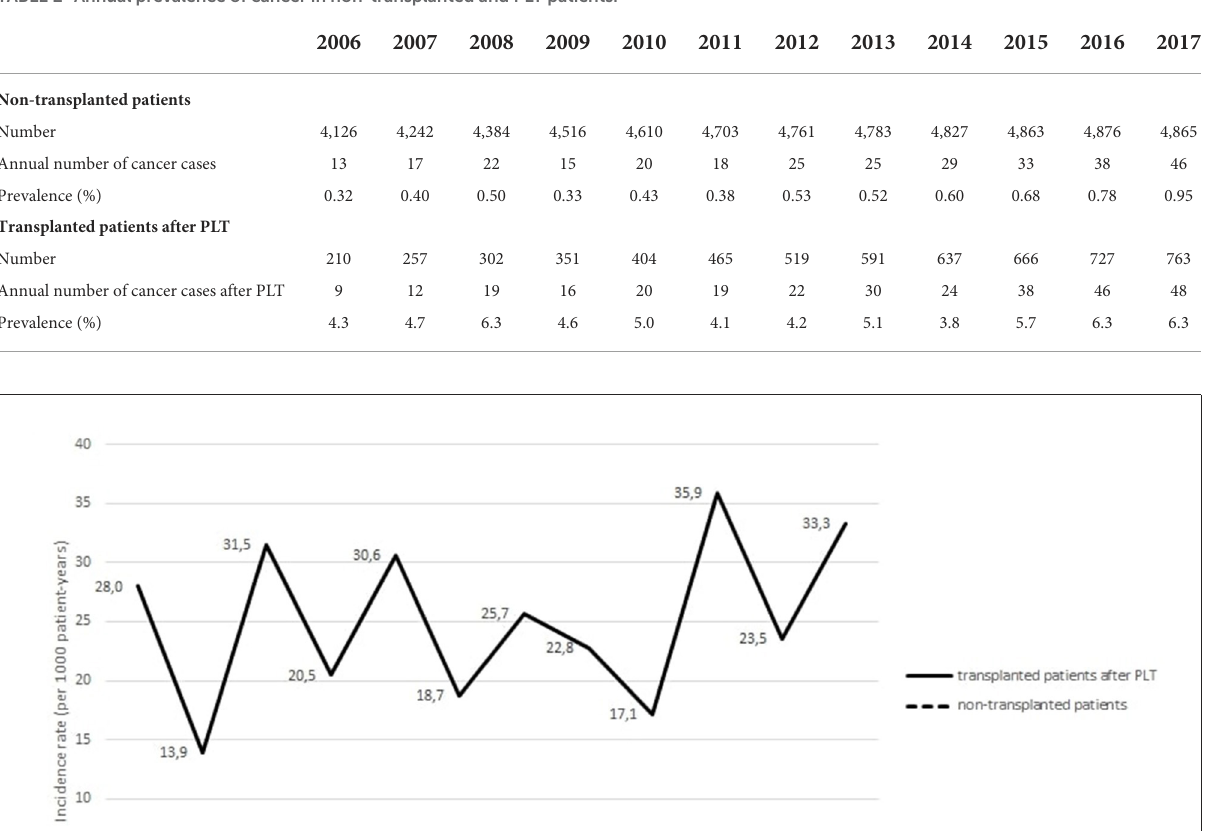
TABLE 2 Annual prevalence of cancer in non-transplanted and PLT patients.